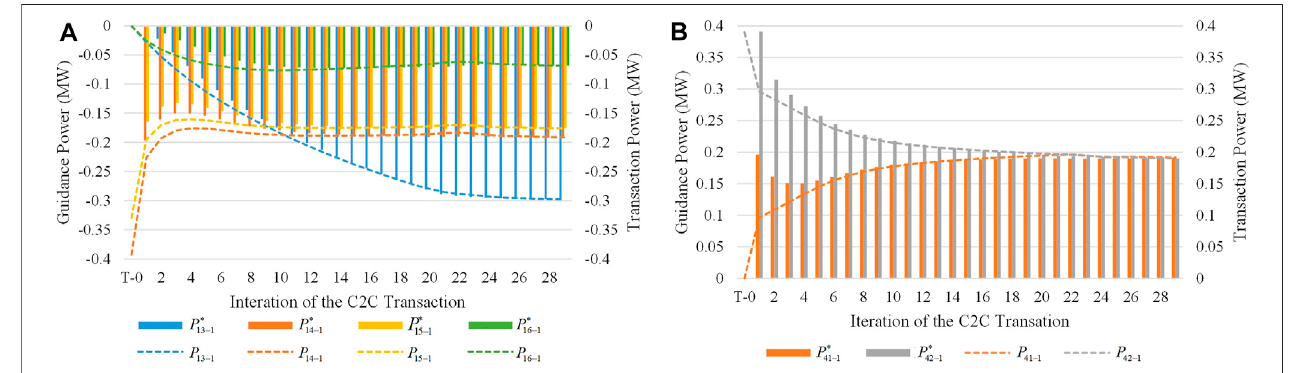
FIGURE 3 | (A) Variation process of transaction power and guidance power of Cell-1. (B) Variation process of transaction power and guidance power of